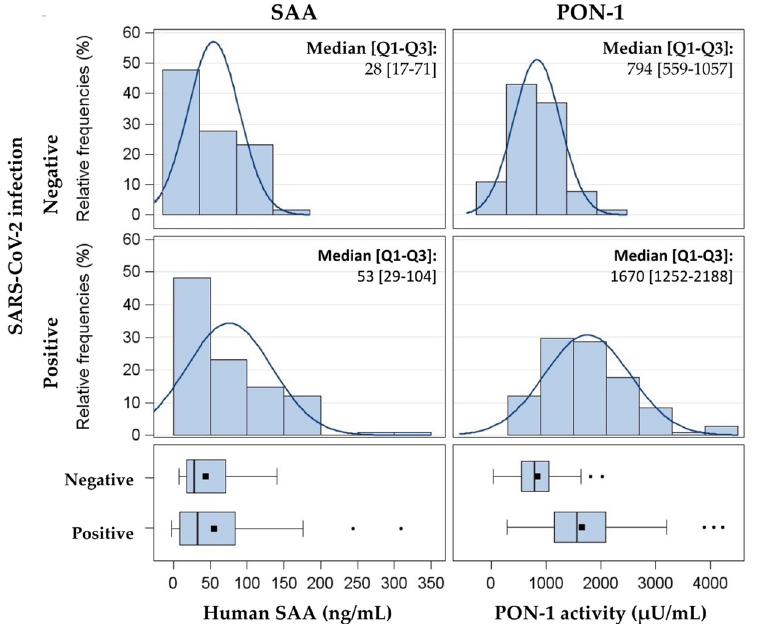
Figure 1. Distribution of SAA (ng/mL) and PON-1 activity ( µ U/mL) in 173 subjects. Data are presented as histograms and box-plots by SARS-CoV2 positivity. SAA, Serum amyloid A; PON-1,